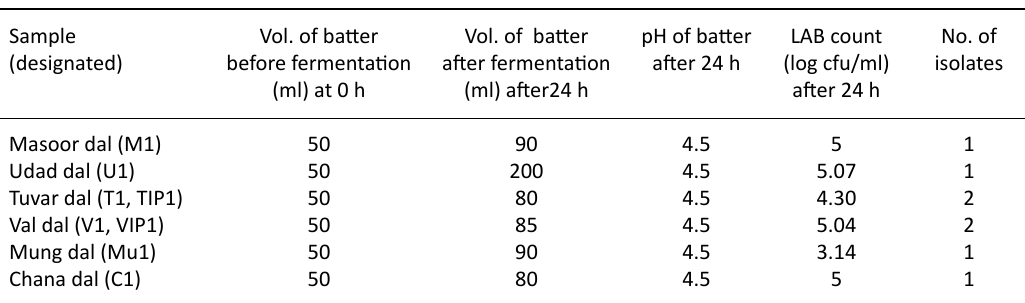
Table 1. Analysis of pulse dal flour during fermentation Sample Vol. of batter Vol. of batter pH of batter LAB count No. of (designated) before fermentation after fermentation after 24 h (log cfu/ml) (ml) at 0 h (ml) after24 h